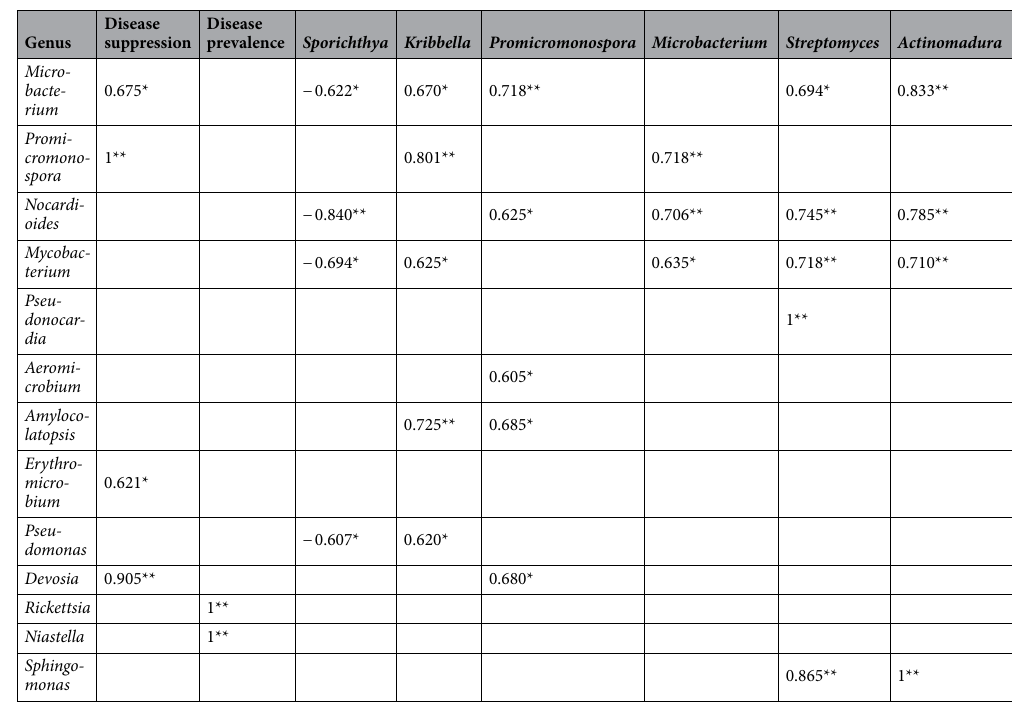
Table 6. Correlation analysis among occurrence of the genera of Actinobacteria with different genera in disease suppression/prevalence. Significant effects are shown as * p < 0.05 and ** p <